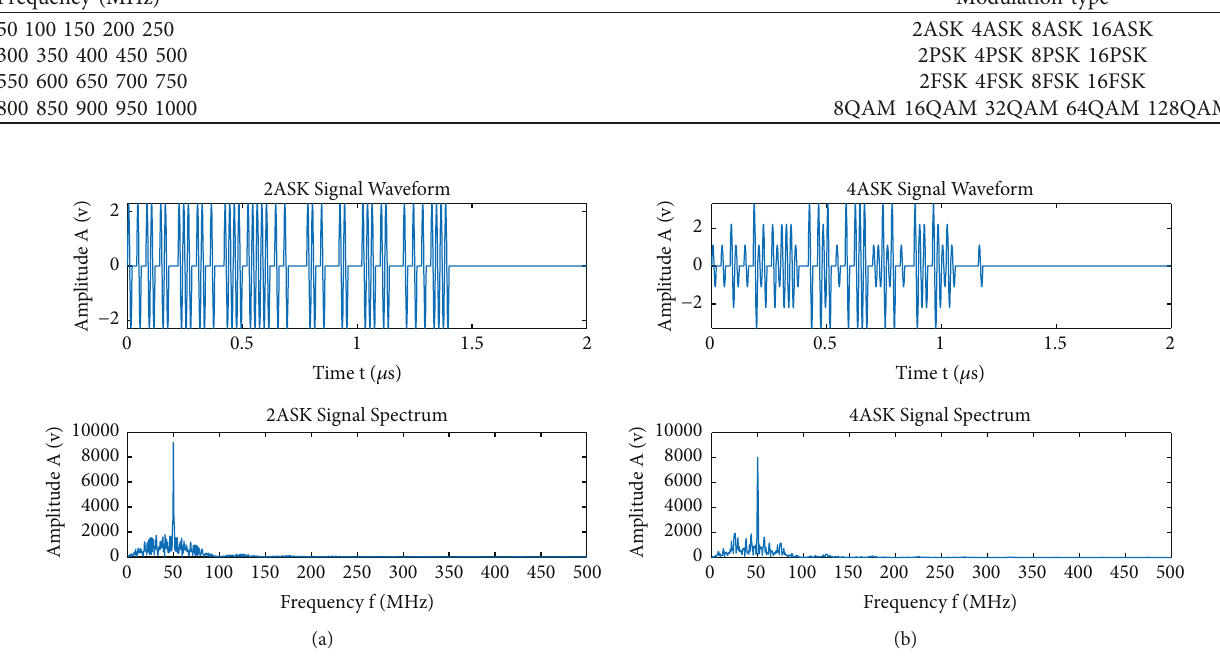
Figure 1: Simulation for (a) 2ASK signal and (b) 4ASK Table 2: Simulation parameters for radar signal.